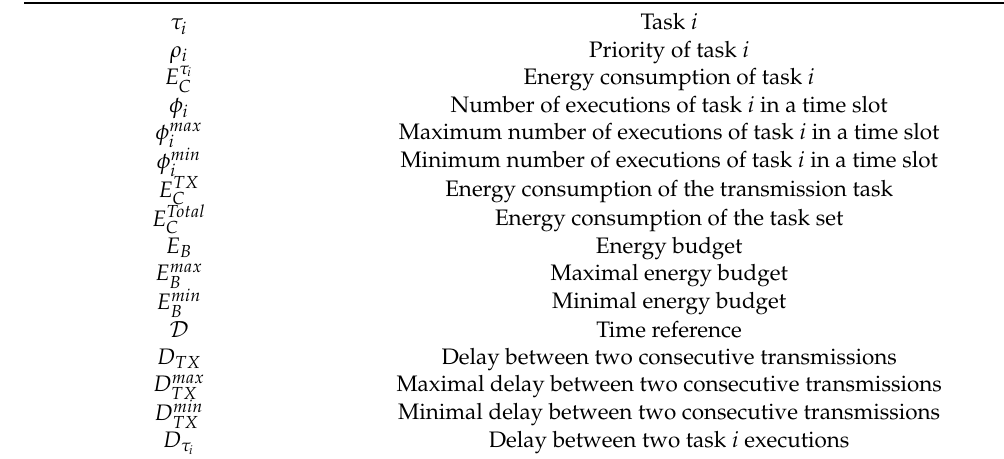
Table 2. Table of Notation—Section 4.2. τ i Task i